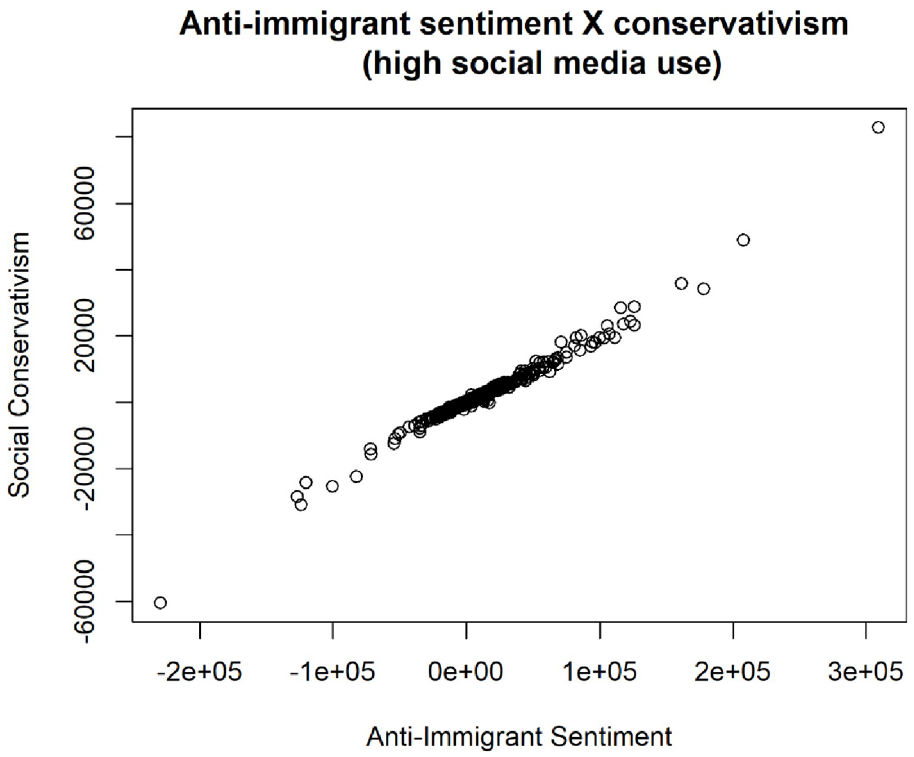
Fig 19. Cluster plot of social political values (both liberalism and conservativism) and anti-immigrant sentiment. On the Y axis, the 0 point could be considered political neutrality, while negative numbers can be considered left-wing and positive numbers can be considered